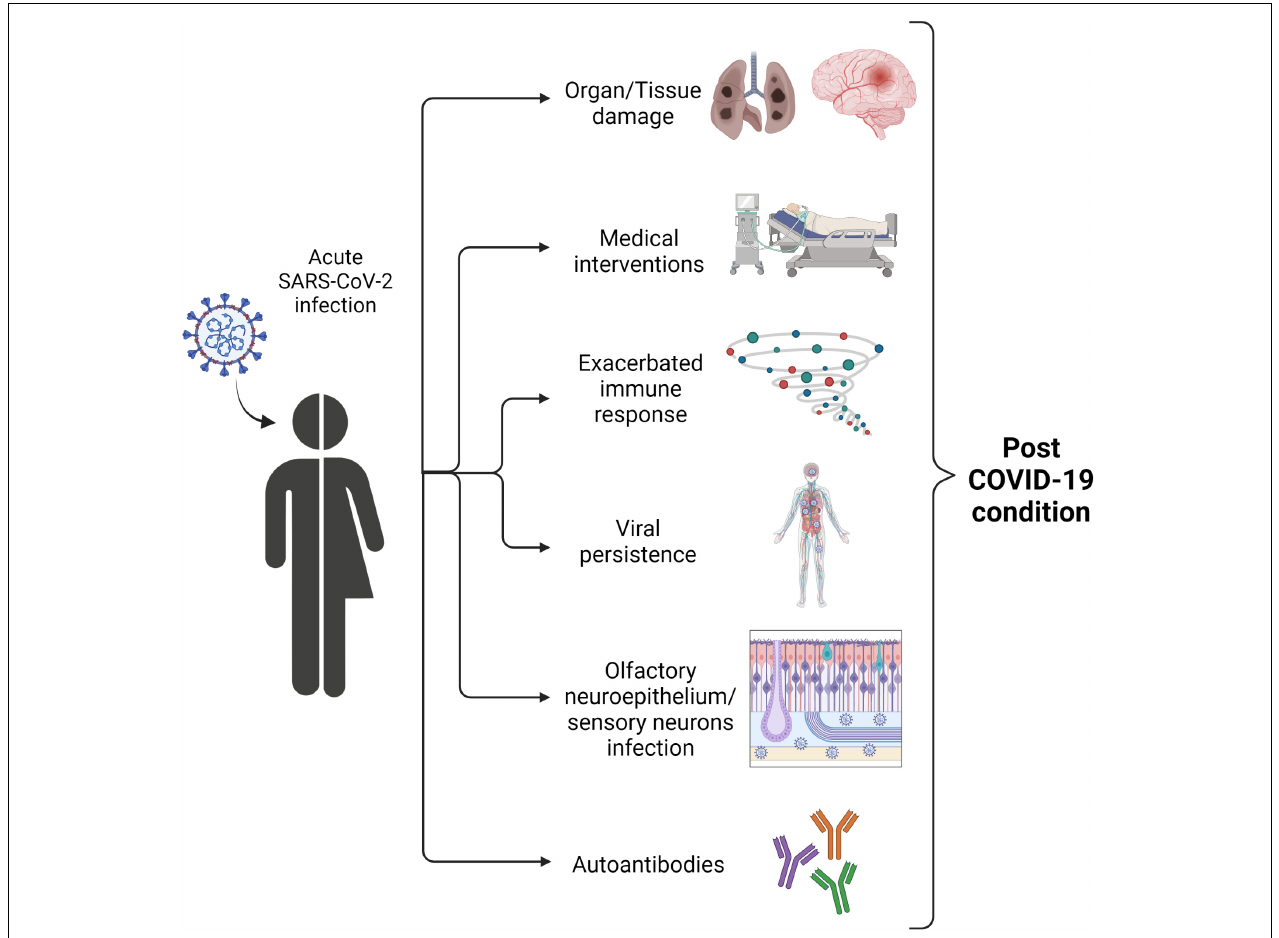
FIGURE 3 | Diagram showing potential pathophysiological mechanisms of post-COVID-19 condition